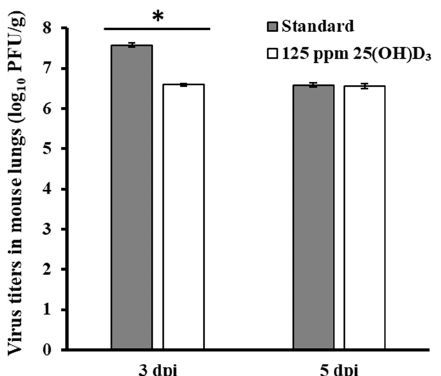
Figure 4. Virus recovery from the lungs of mice challenged with PR8 (H1N1) at 3 or 5 dpi. Mice were fed a standard diet or a diet supplemented with 125 ppm 25(OH)D 3 for 7 weeks and then challenged with PR8 (H1N1) intranasally. The viral titers in the lung homogenates at 3 or 5 dpi were measured (PFU / g) for each group ( n = 6 mice / group). *, significant di ff erence ( p < 0.05). Nutrients 2020 , 12 , x FOR PEER REVIEW